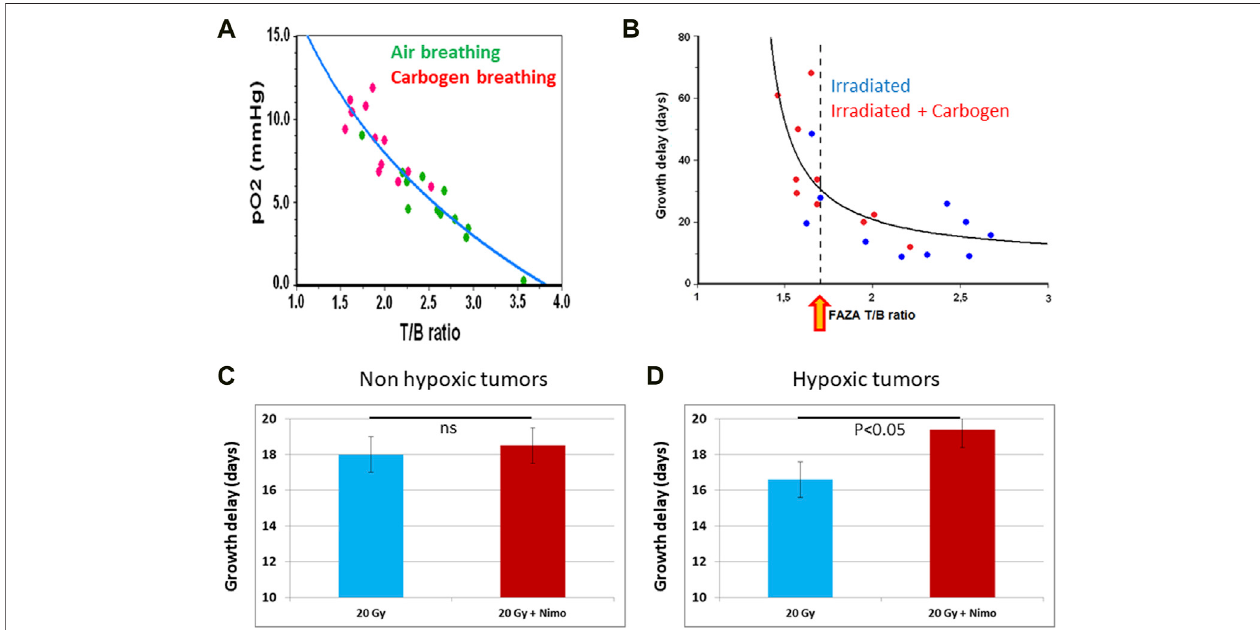
FIGURE 8 | 18 F-FAZA as predictor of tumor response to radiation therapy. (A) In vivo calibration of 18 F-FAZA tumor accumulation (measured by microPET) as a functionoftumorpO 2 (measuredbyEPRoximetry)inthesamerhabdomyosarcomatumors. (B) Growthtimedelayasafunctionoftumoruptakeof 18 F-FAZA(measured by microPET) in cohorts of animals breathing air or carbogen. The yellow arrow indicates a tumor-to-background ratio (T/B) corresponding to 10 mmHg (higher T/B means more hypoxic than this value while lower T/B means less hypoxic). (C,D) Value of 18 F-FAZA tumor accumulation to predict the outcome of a treatment combiningnimorazoletogetherwithirradiation. (C) fornon-hypoxictumors,nosigni fi cantbene fi t( p > 0.05)wasobservedwhentumorsweretreatedbyacombinationof irradiation together with nimorazole ( n = 7) compared to tumors treated with irradiation alone ( n = 7). (D) for hypoxic tumors, a signi fi cant bene fi t was observed when tumors were treated by a combination of irradiation together with nimorazole ( n = 9) compared to tumors treated with irradiation alone ( n = 5). The fi gures are built with data from (Tran et al., 2012), (Tran et al., 2014), and (Tran et al.,